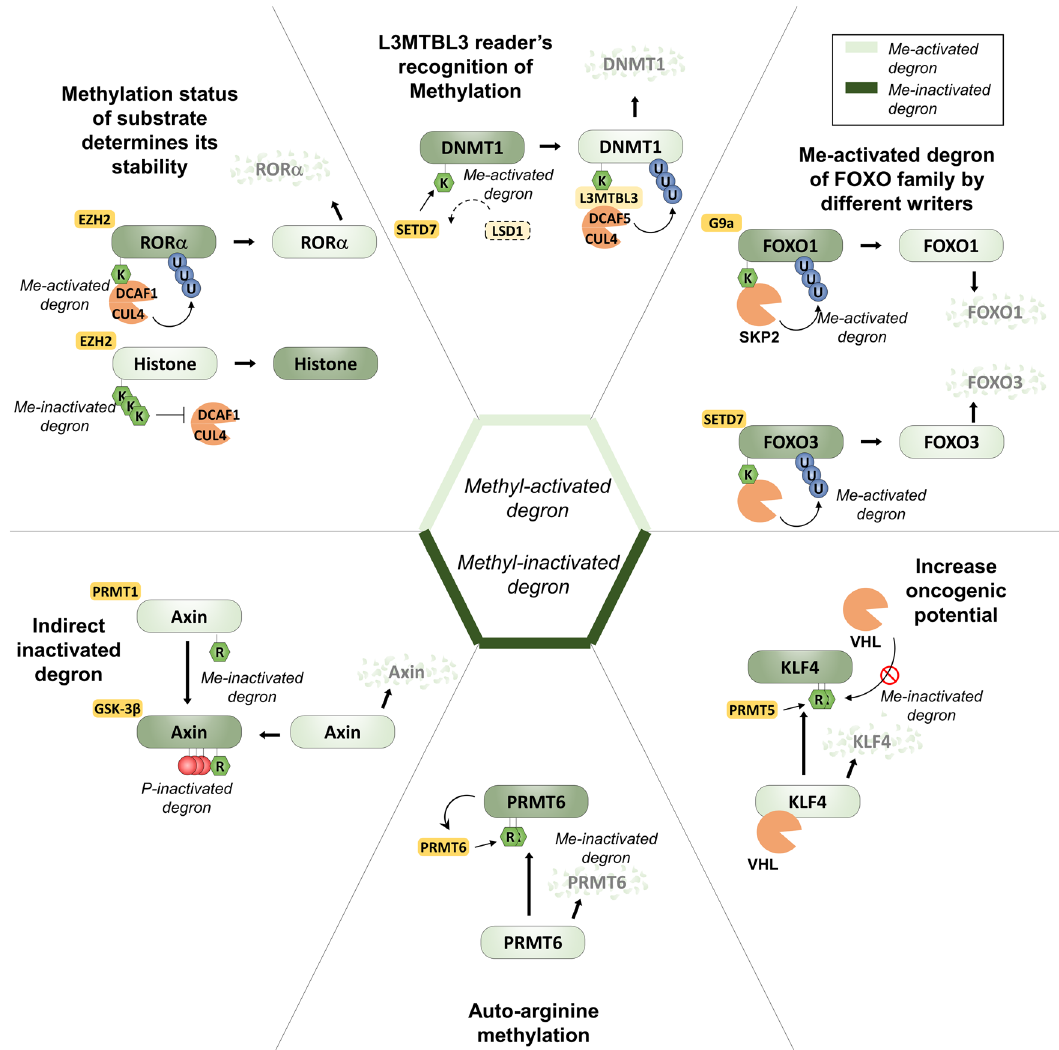
Fig. 2 | Molecular function of lysine and arginine methylation in control of proteinstability. Lysineandargininemethylationregulatesthefunctionofprotein by altering stability. Of note, lysine methylation converts protein stability nega- tively by methyl-degron (light green) and arginine methylation mainly increases